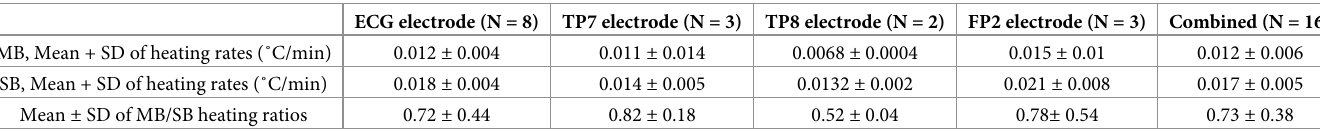
Table 1. Comparison of average heating of the MB and SB protocols at the ECG, TP7, TP8 and FP2 electrodes in the watermelon